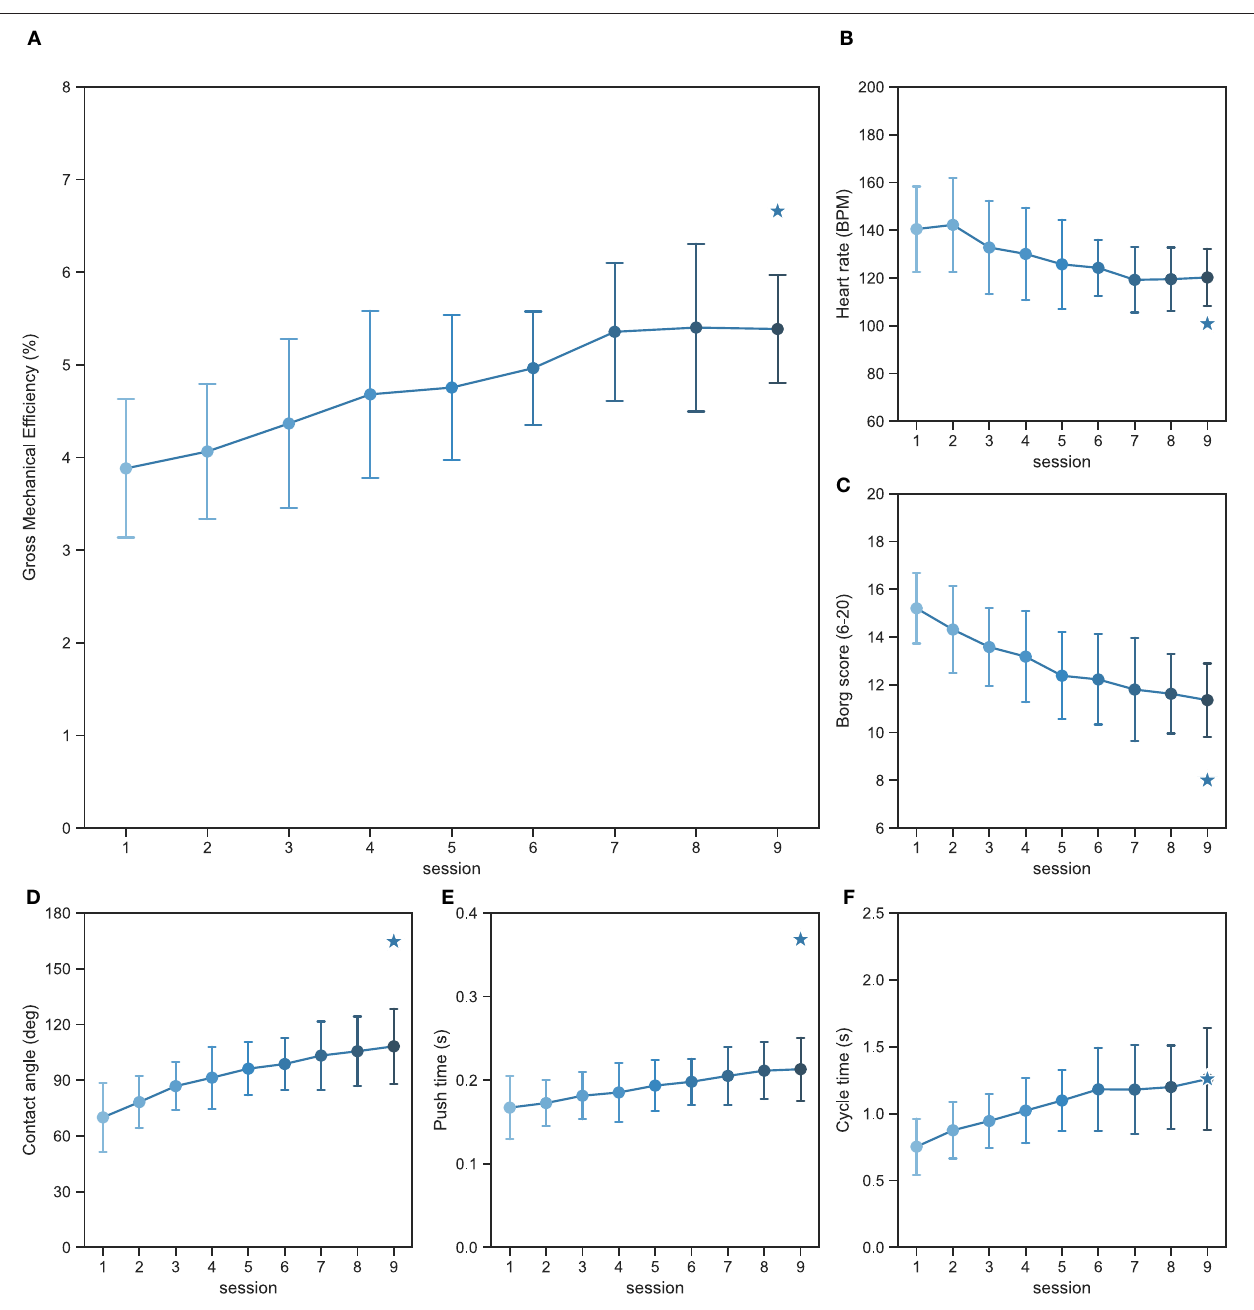
FIGURE 3 | (A–F) Outcomes for six metabolic and kinetic parameters aggregated (mean and standard deviations, n=15) by session ( ⋆ =athlete). All variables shown significantly changed over time. The athlete scored significantly “better” on all parameters shown, except for cycle time (D)